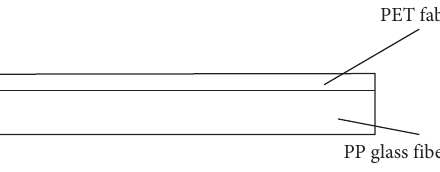
Figure 2: Schematic configurations of the composite layers. Table 3: Proposed GMT sheet glass fiber ratio and thickness